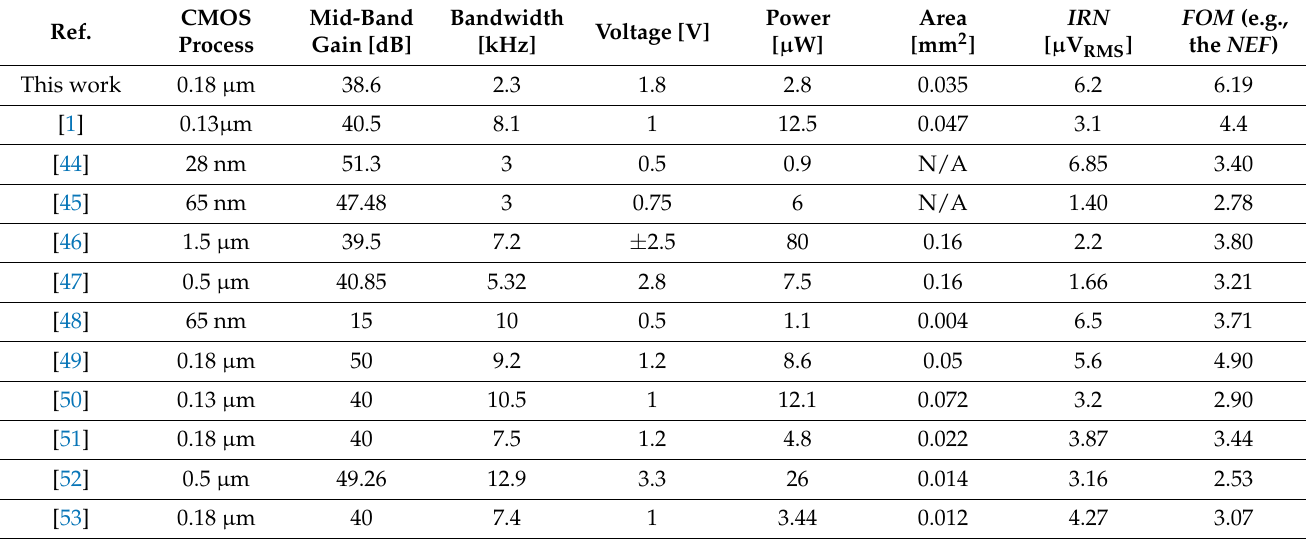
Table 2. Comparison of this low-noise amplifier with the state of the art.